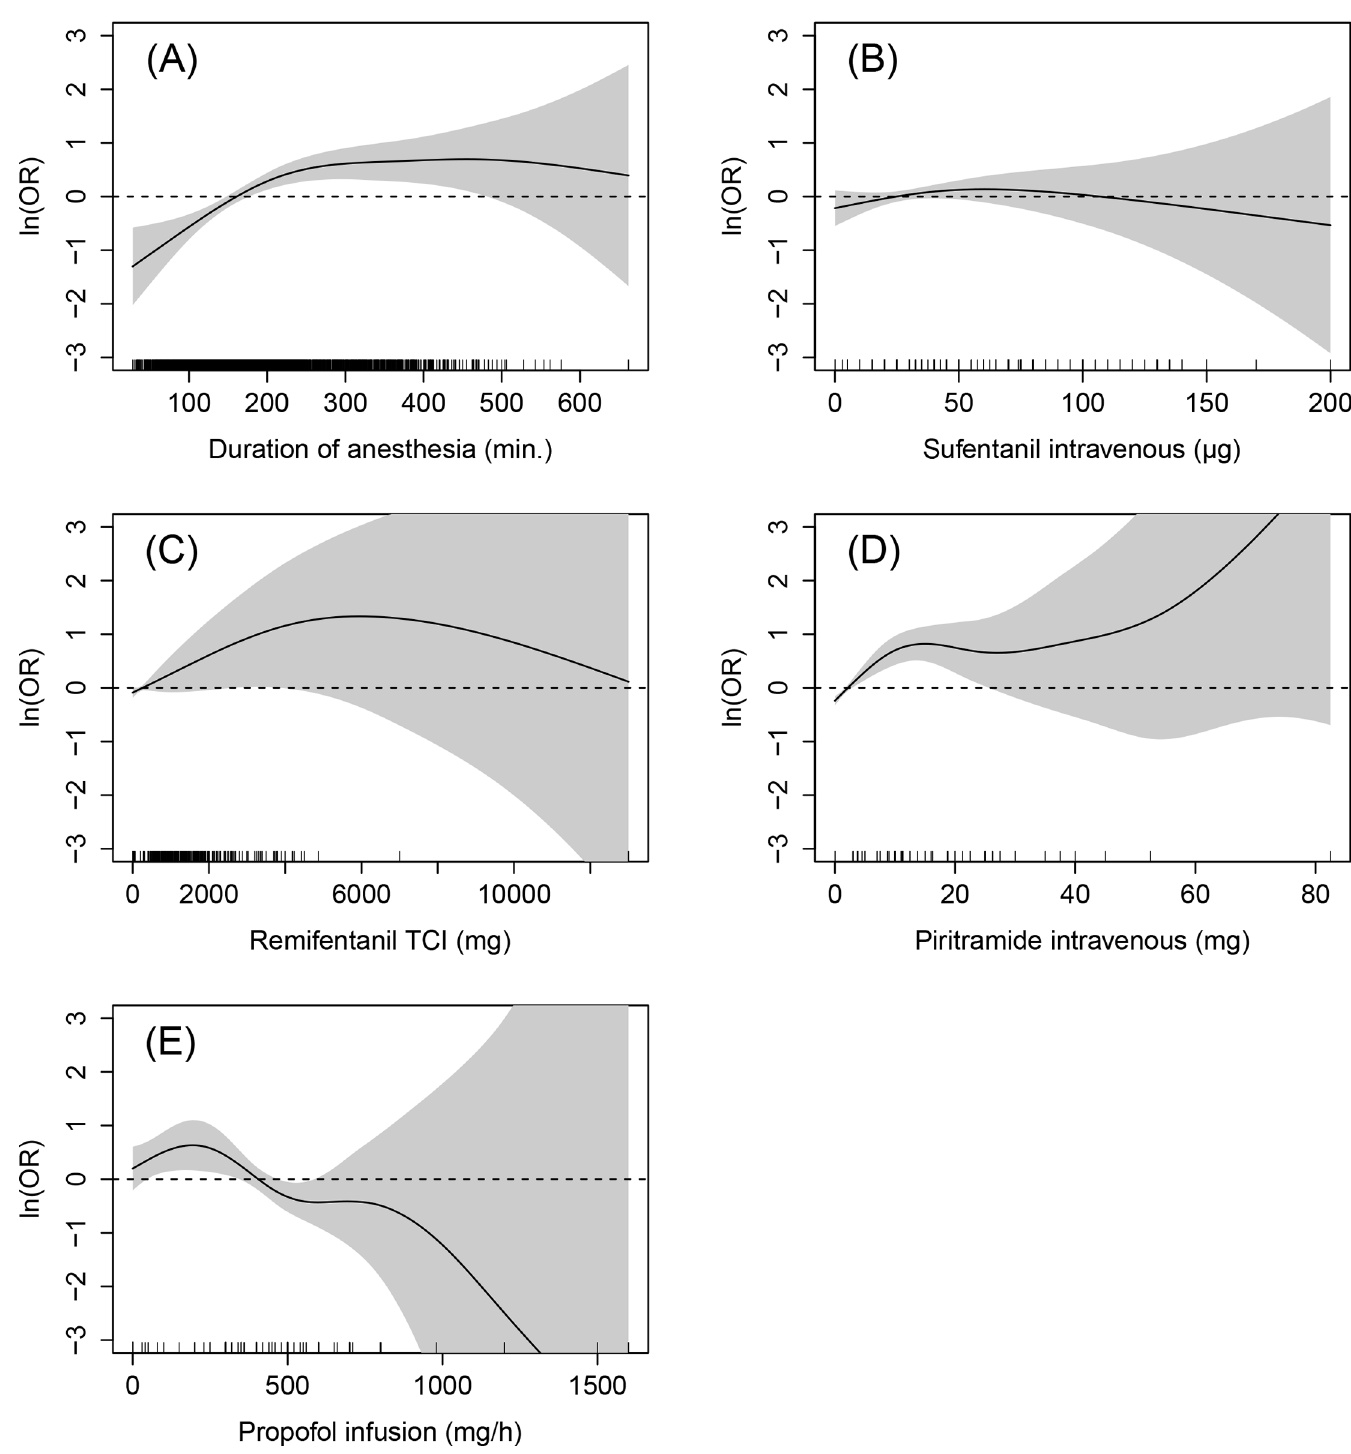
Fig 3. Nonlinear covariate effects. Estimated nonlinear effects of anesthesia duration (A), intravenous sufentanil (B), remifentanil TCI total dosage (C), piritramide intravenous (D) and propofol infusion maximum rate (E). The solid black line visualizes the estimated effect (measured on log OR scale), the grey region corresponds to the 95% pointwise confidence interval for the estimated effect. The marks along the x-axis indicate the observed covariate values in the data.